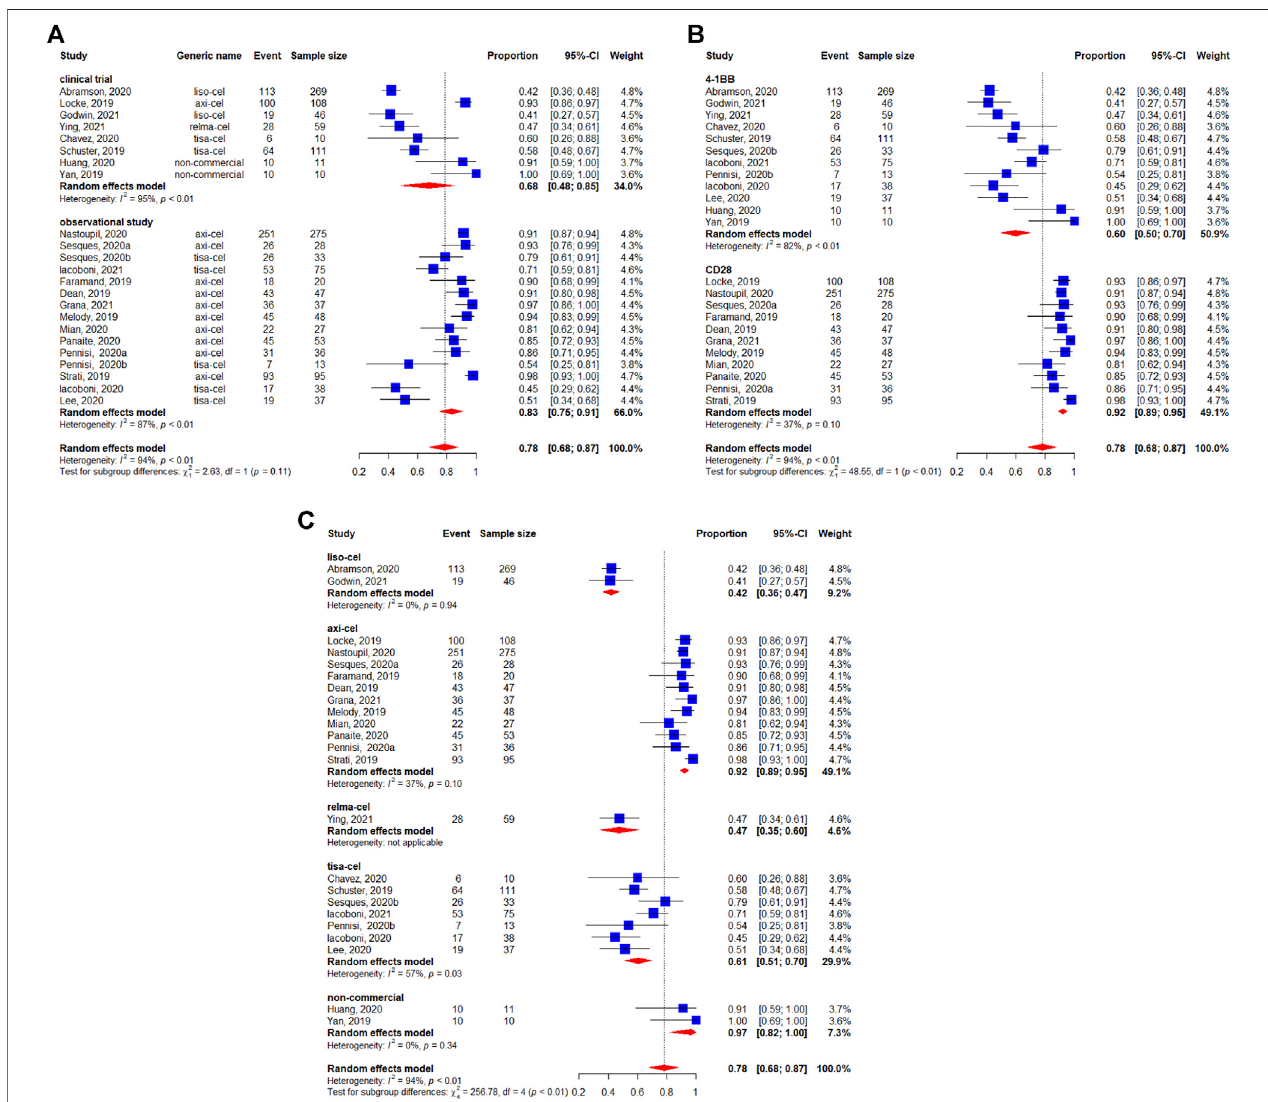
FIGURE 6 | Any - grade cytokine release syndrome (CRS) of patients with diffuse large B-cell lymphoma (DLBCL) treated with chimeric antigen receptor T cells (CAR-Ts) according to (A) study design, (B) the costimulatory domain, and (C) type of chimeric antigen receptor T cells (CAR-T).